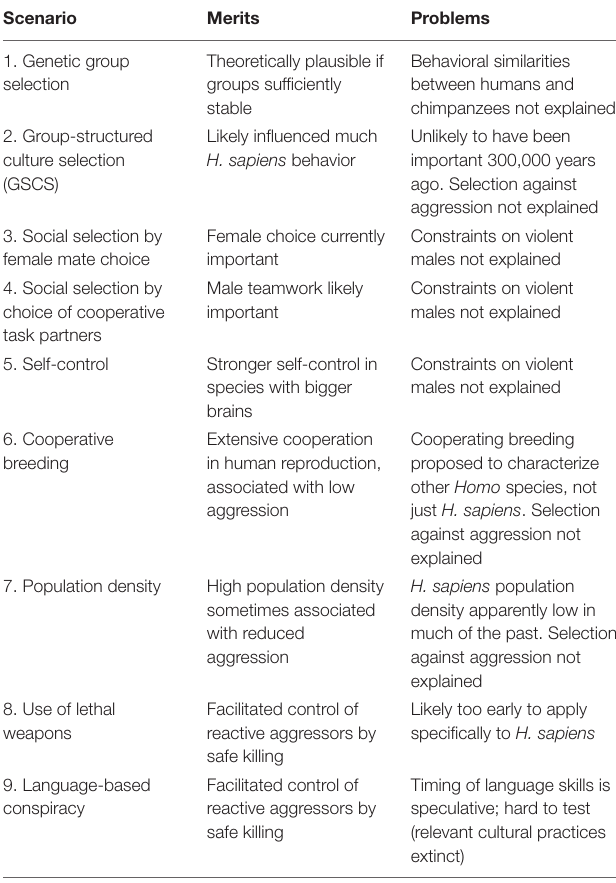
TABLE 1 | Evolutionary scenarios for selection against reactive aggression (i.e., self-domestication) in human evolution, applied to Homo sapiens